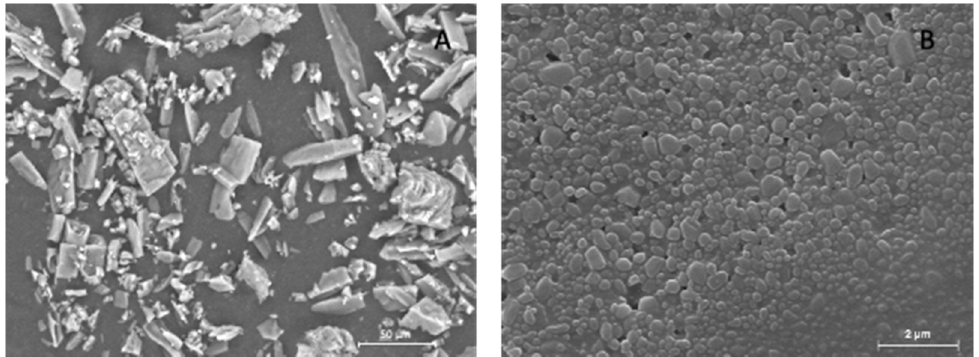
Figure 1. Scanning electron microscopy images of DCF raw material ( A ) and DCF nanocrystals ( B